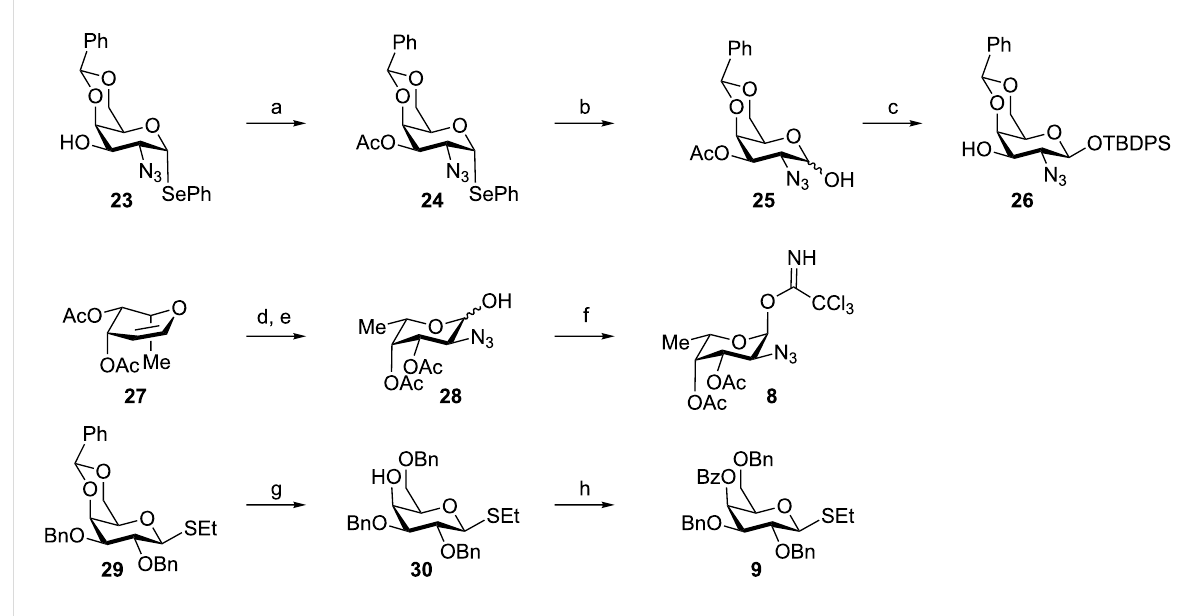
Scheme 5: Synthesis of monosaccharide building blocks 8 , 9 and 26 . Reagents and conditions: (a) acetic anhydride, pyridine, CH 2 Cl 2 , rt, 18 h, 82%; (b) NIS, THF/H 2 O (1:1), rt; (c) 1) TBDPSCl, imidazole, DMF, rt; 2) NaOMe, MOH, rt, 68% over two steps; (d) (PhSe) 2 , BAIB, NaN 3 , CH 2 Cl 2 , rt, 24 h; (e) NIS, THF/H 2 O (1:1), rt, 80% over two steps; (f) CCl 3 CN, DBU, CH 2 Cl 2 , 0 °C to rt, 2 h, 72%; (g) TES, TFA, CH 2 Cl 2 , 0 °C, 6 h; (h) benzoyl chloride, pyridine, rt, 18 h, 80% over two steps.